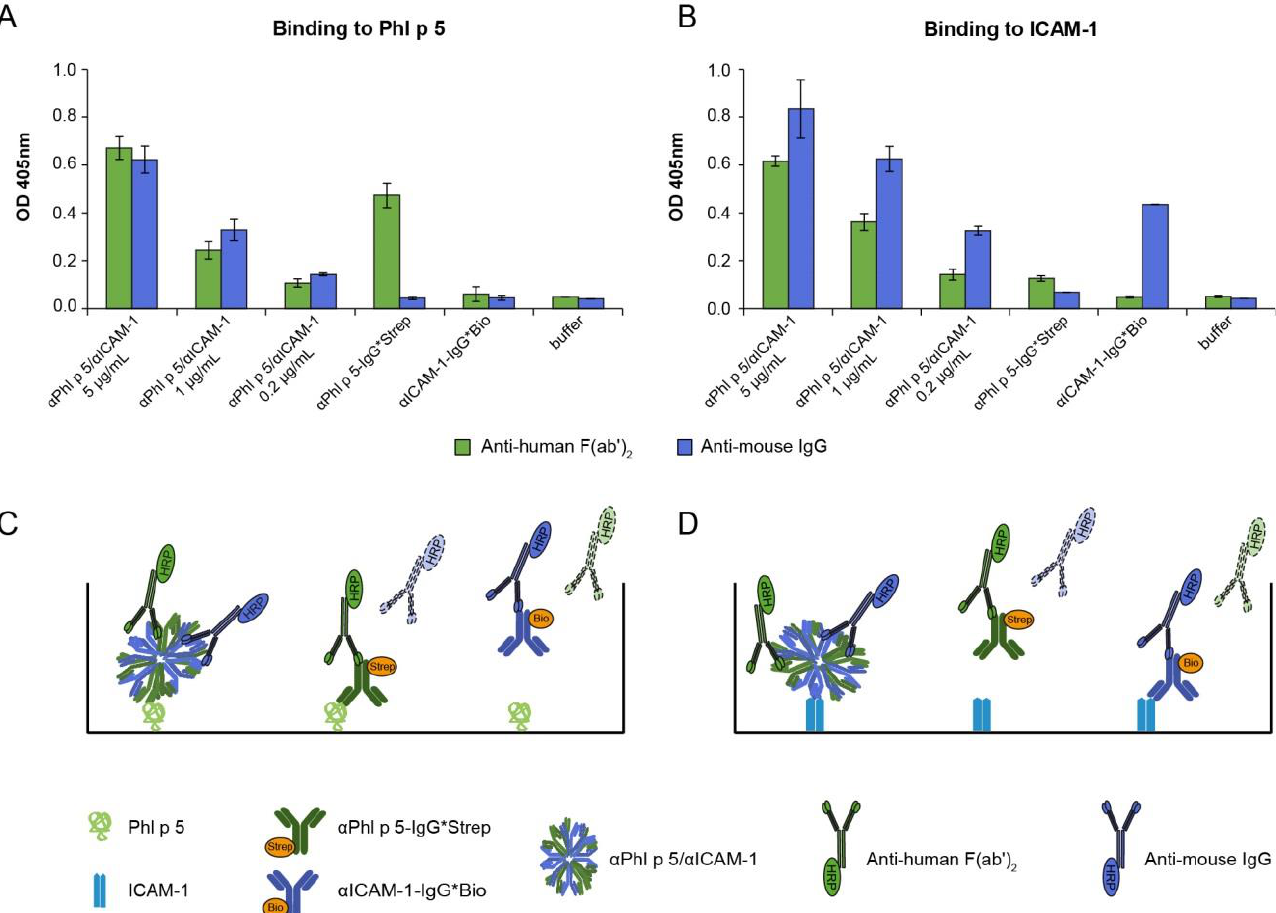
Figure 1. Antibody conjugates ( α Phl p 5/ α ICAM-1) bind to Phl p 5 and human ICAM-1. Conjugates formed with α Phl p 5-IgG*Strep and α ICAM-1-IgG*Bio ( x -axes: α Phl p 5/ α ICAM-1; 5 µ g/mL, 1 µ g/mL and 0.2 µ g/mL), α Phl p 5-IgG*Strep or α ICAM-1-IgG*Bio alone were tested for reactivity to Phl p 5 ( A ) and ICAM-1 ( B ) and detected by anti-human F(ab ´ ) 2 (green bars) or anti-mouse IgG (blue bars). Optical density (OD) values ( y -axes) corresponding to bound α Phl p 5/ α ICAM-1 conjugates, α Phl p 5-IgG*Strep or α ICAM-1-IgG*Bio are shown as means of 10-fold analysis (deriving from duplicate determination of five independent experiments) ± standard deviation (SD)s. ( C , D ) are schematic representations of the experiments in ( A , B